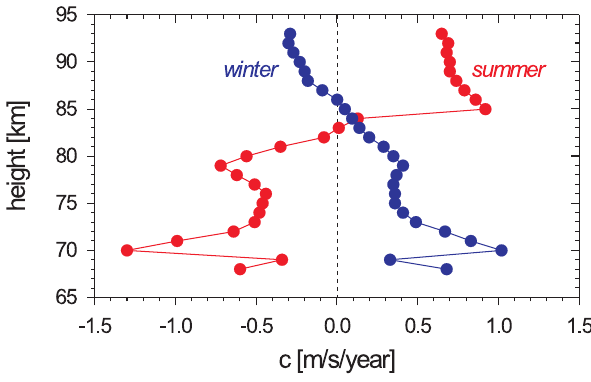
Fig. 14. Trend of the mesospheric zonal wind at Juliusruh (partial regression coefficient c due to Eq. 1) with a dependence on height for summer (red) and winter